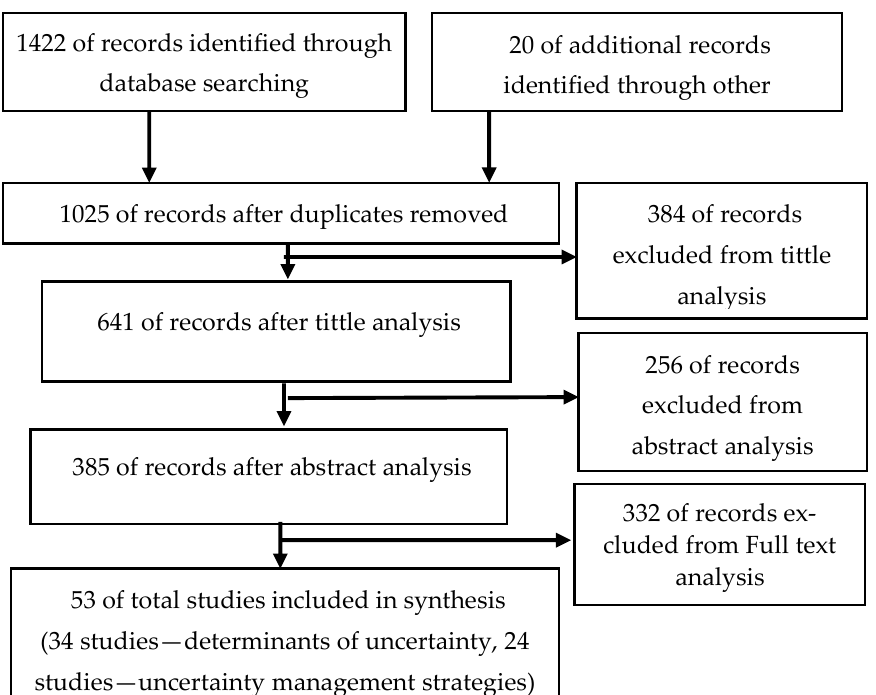
Figure 2. Stages of the material selection process (Adapted from [43]) .